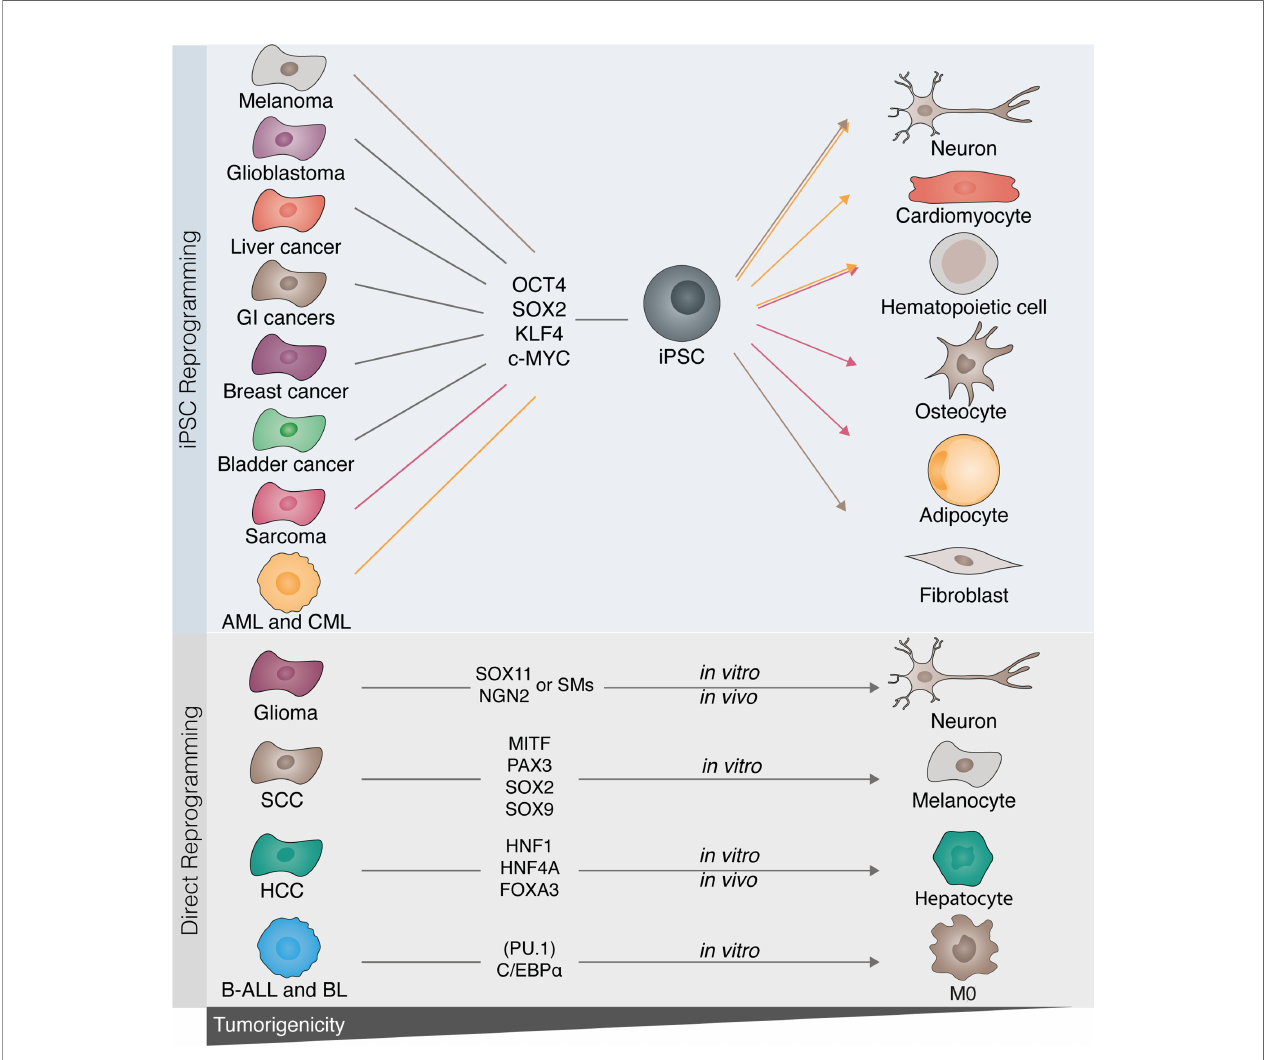
FIGURE 3 | Disrupting cancer cell tumorigenicity with cellular reprogramming. Several tumor cell types have been described to be amenable to cell reprogramming towards induced pluripotent stem cells (iPSCs). Melanoma, glioblastoma, sarcoma, gastrointestinal (GI), as well as breast, bladder, and liver cancers, acute myeloid leukemia (AML), and chronic myelogenous leukemia (CML) have all been successfully reprogrammed towards iPSC with OCT4, SOX2, KLF4, and c-MYC. Following reprogramming to iPSCs, cancer cells can be differentiated into benignity by either differentiation to their original cell type or by converting them into a different lineage (highlighted by the colored lines). Similarly, in vitro direct reprogramming has been demonstrated in glioma, B-cell acute leukemia (B-ALL), Burkitt lymphoma (BL), squamous cell carcinoma (SCC), and hepatic cellular carcinoma (HCC). Lineage-speci fi c factors rewrite the cancerous epigenetic and transcriptional program into mature terminally differentiated cells (glioma to neuron; SCC to melanocyte; HCC to hepatocyte), or by modifying cell fate and therefore disrupting the tumorigenic drive [B-leukemias to macrophage